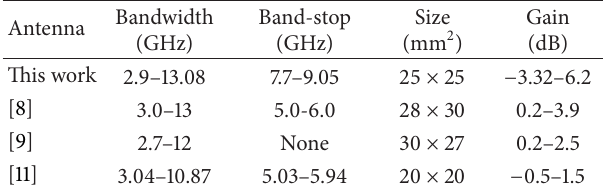
Table 2: Figure of merit comparison of some differential